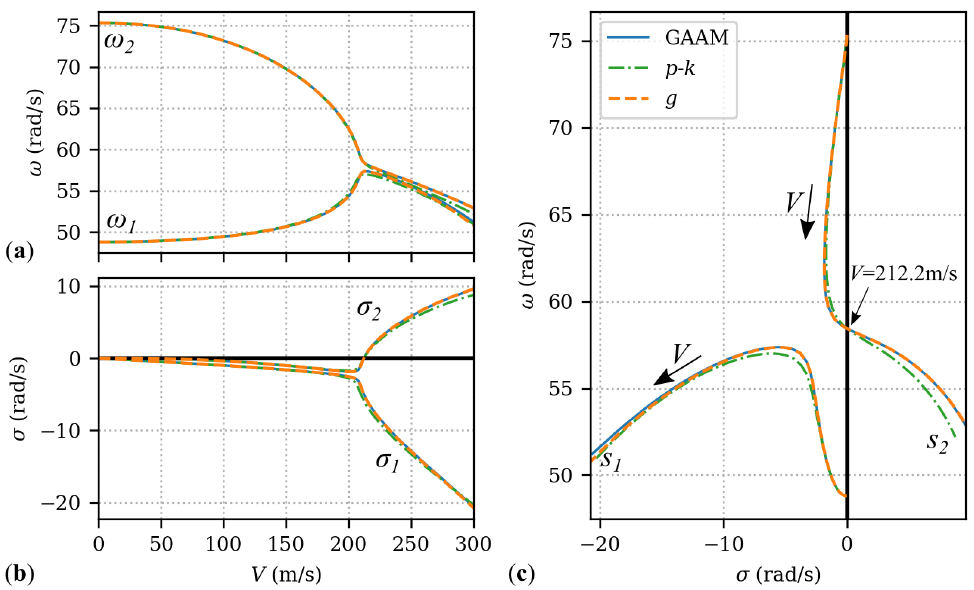
Figure 2. Eigenvalue solutions of the nonlinear aeroelastic eigenproblem for the typical section model employing the p - k method, the g method and GAAM for freesteam velocities from 0 m/s to 300 m/s with the flutter onset velocity at 212.2 m/s. ( a ) Angular frequencies. ( b ) Damping coefficients. ( c ) Eigenvalues in the complex